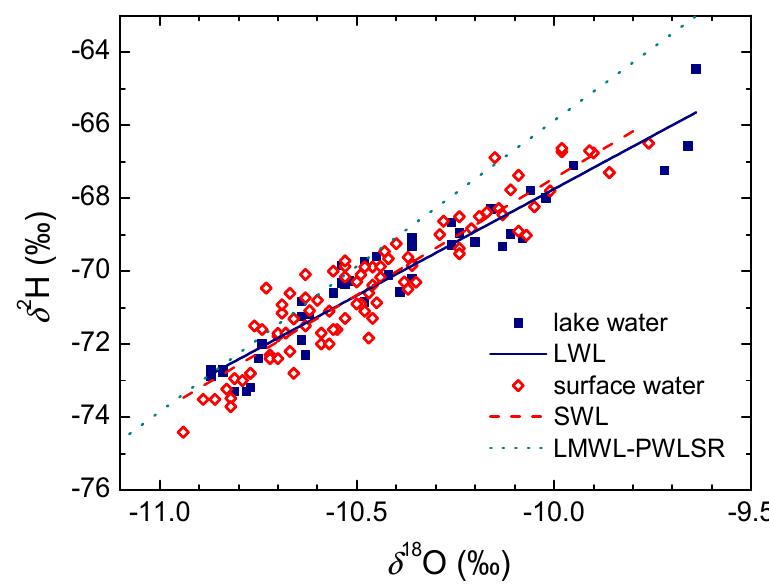
Figure 15. A relation of δ 2 H vs. δ 18 O for the surface and lake waters at the Plitvice Lakes, 2011–2014.